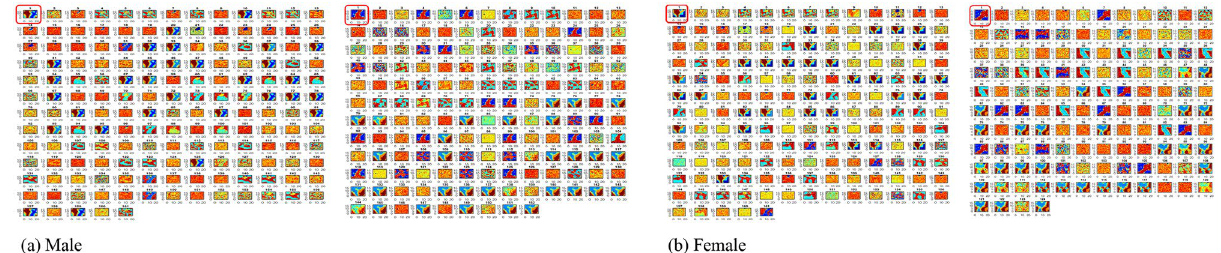
Figure 6. SOM component planes visualization for European isolates. Component planes 1 (encircled) represent the SARS-CoV-2 reference genome. The male and female isolates have 2 SOM maps each with country and (component plane map position(s)) distributed as follows: Male—( a ) Map 1: Switzerland (2), Faroe Island (3–7), Belgium (8–9), Poland (10–23), Greece (14–29), Romania (30–43), Spain (44–102), Georgia (103–105), Italy (106–161). Map 2: Italy (2–59), Russia (60–73), France (74–112), Slovakia (113), Hungary (114–118), Cyprus (119), Ukraine (120–125), Sweden (126), Austria (127), Croatia (128–129), Bosnia and Herzegovina (130), Czech Republic (131–152). Female—( b ) Map 1: Switzerland (2), Faroe Islands (3–6), Belgium (7–8), Greece (9–19), Germany (20–26), Romania (27–47), Spain (48–95), Georgia (96), Italy (97–161). Map 2: Italy (2–28), Russia (29–55). France (56–87), Slovakia (88–90), Moldovia (91–93), Hungary (94–100), Ukraine (101–104), Austria (105), Finland (106), Bosnia and Herzegovina (107), Czech Republic (107–123).